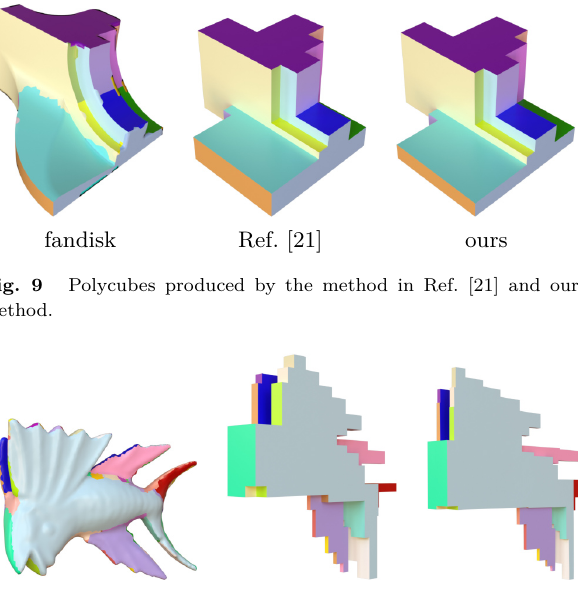
woodenfish Ref. [21] ours Fig. 10 Polycubes produced by the method in Ref. [21] and our method.